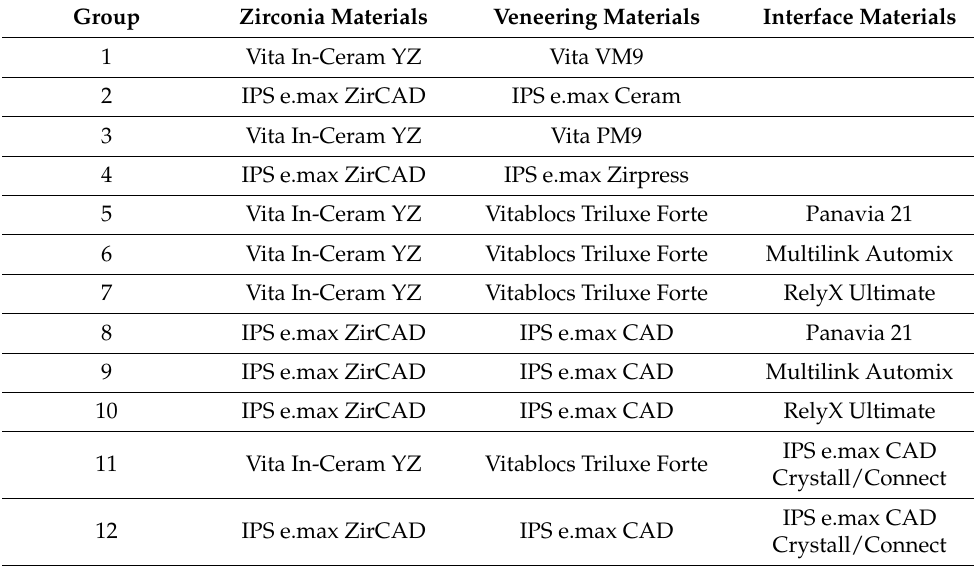
Table 1. Experimental